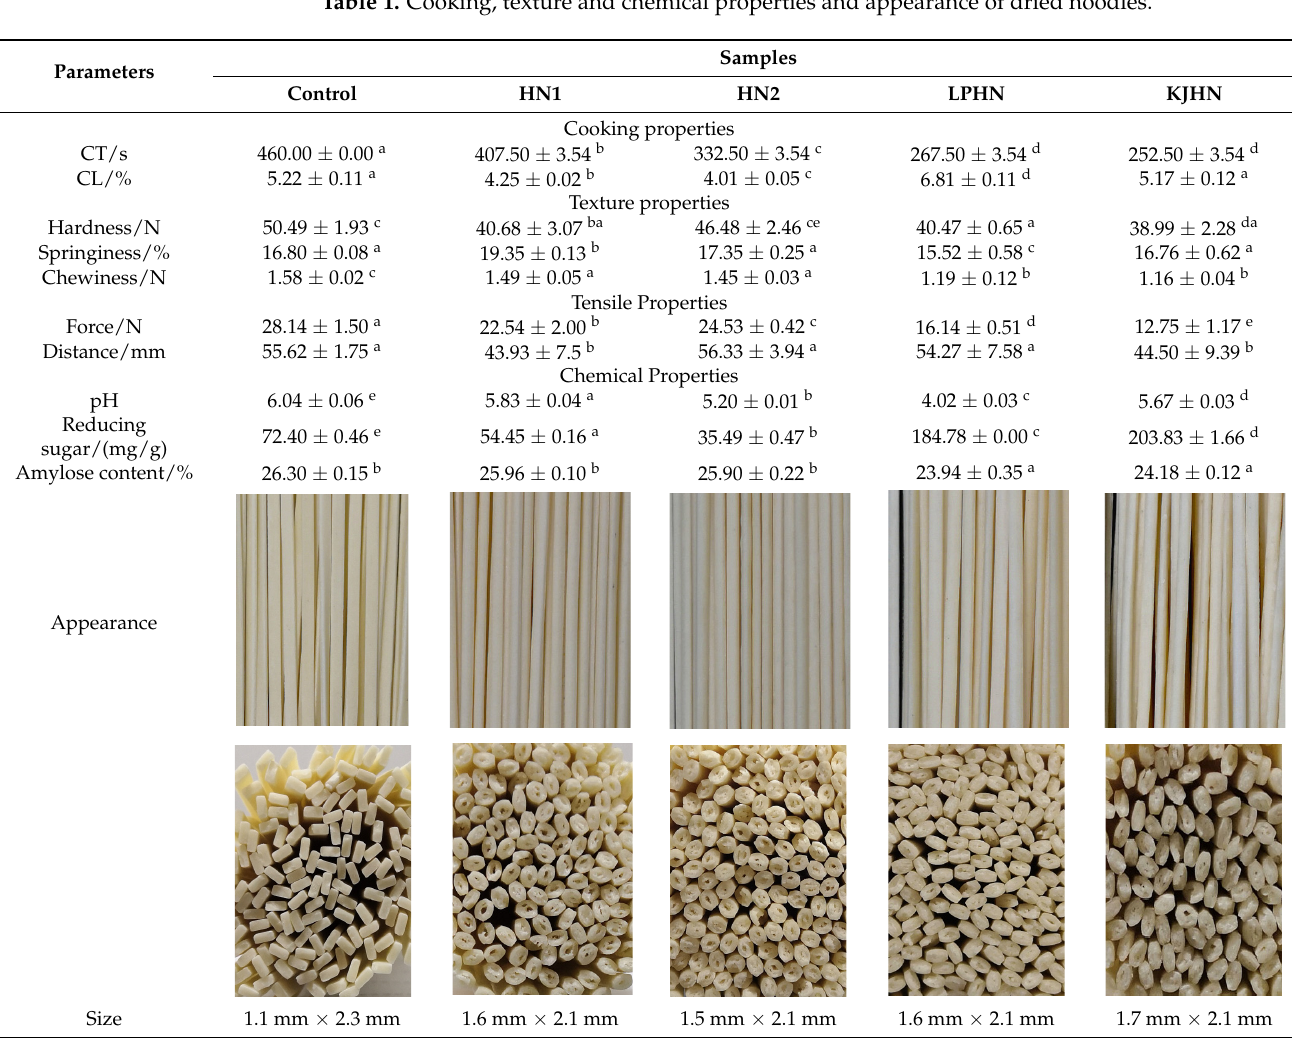
Table 1. Cooking, texture and chemical properties and appearance of dried noodles.